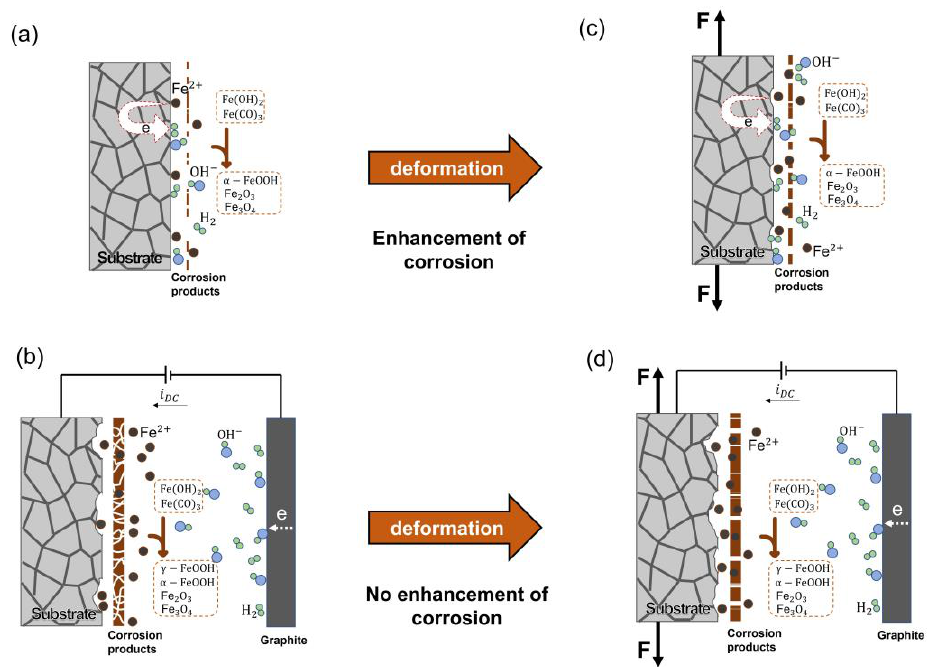
Figure 15. Schematic diagram of X80 steel during corrosion under the applied DC and strain. ( a ) natural corrosion; ( b ) strain applied; ( c ) DC current applied; ( d ) DC current and strain applied.